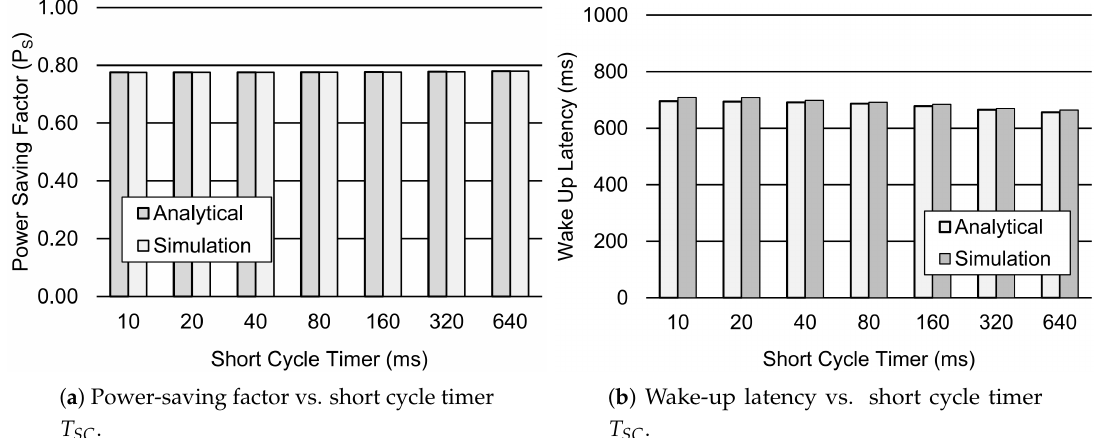
Figure 9. Performance analysis of the DRX mechanism for different values of T SC . Other parameter settings include 1 T tail = 11.576